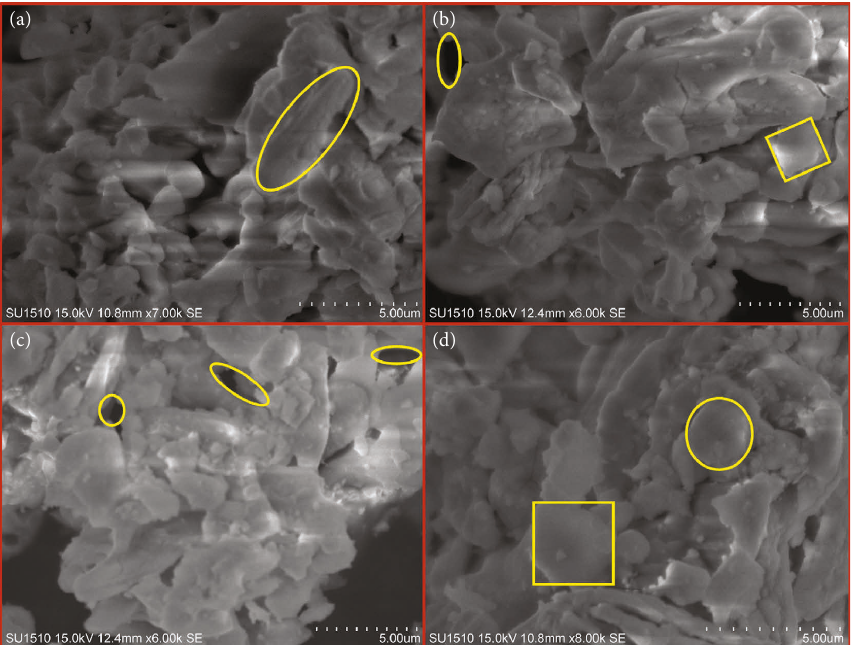
Figure 3: SEM image of the La